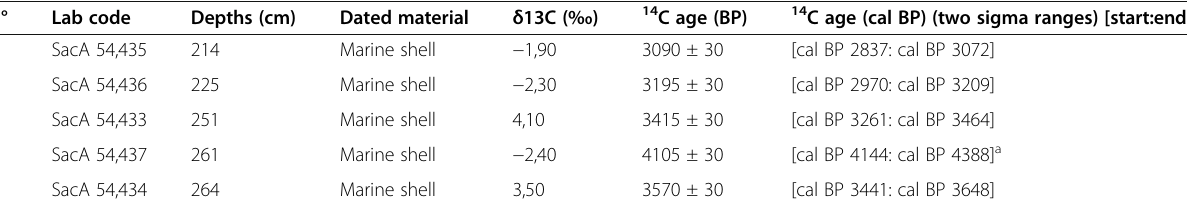
Table 2 Calibrated 14 C ages of samples taken from the TAH17 – 1 core. Sample with asterisk marks remobilized material (see text for explanation)